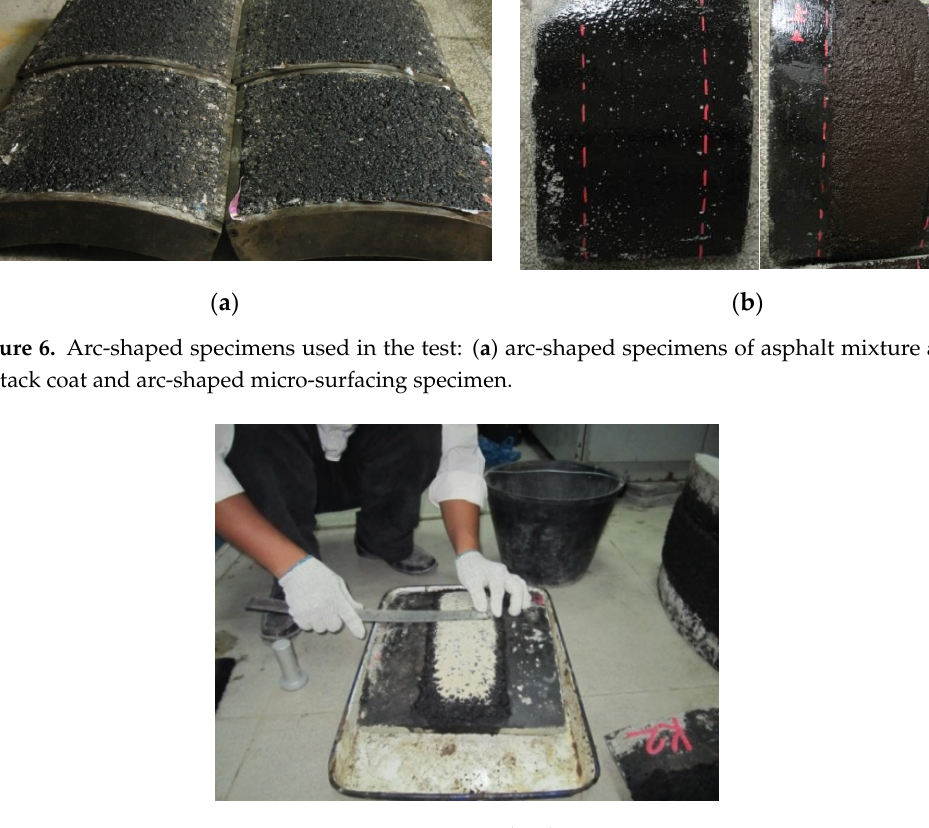
Figure 7. Texture depth test.